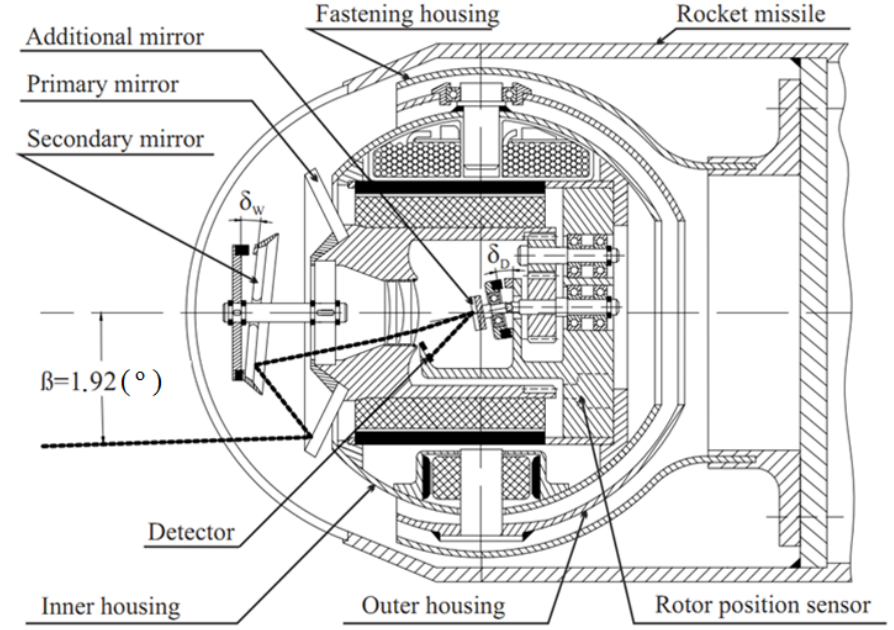
Figure 2. Scanning and tracking seeker set in the first operating mode.